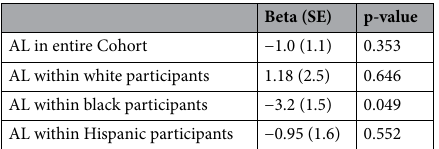
Table 2. Comparison of AL load and associated TICS at discharge between White, Black and Hispanic